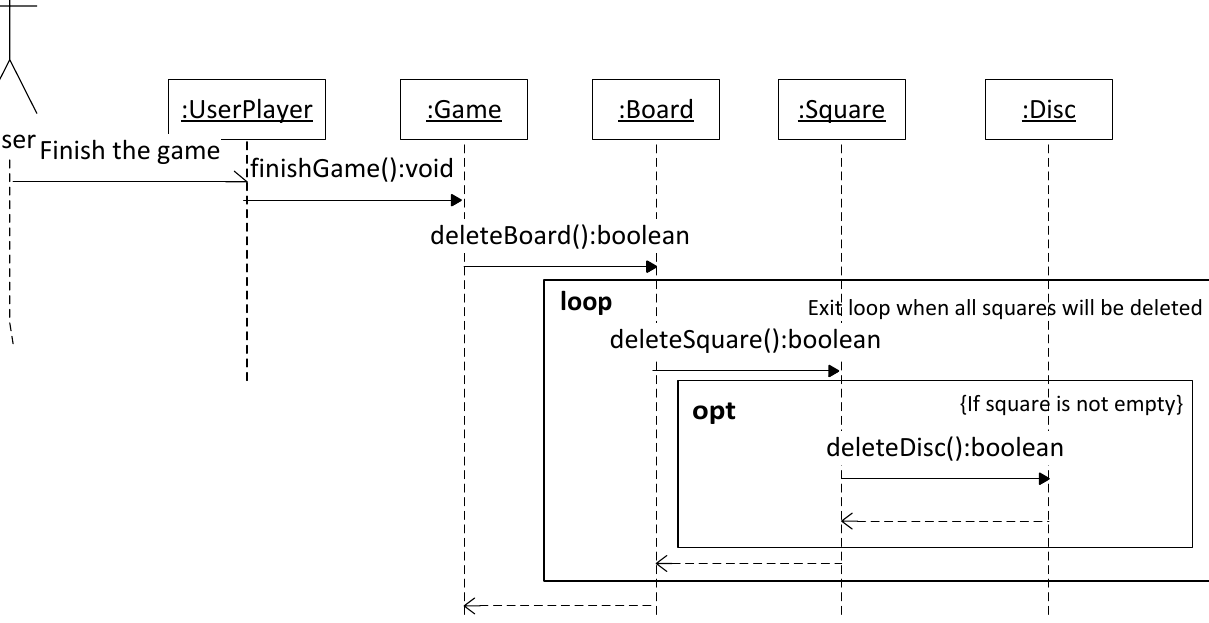
Fig. 3. The UML sequence diagram with the system goal “Finish the